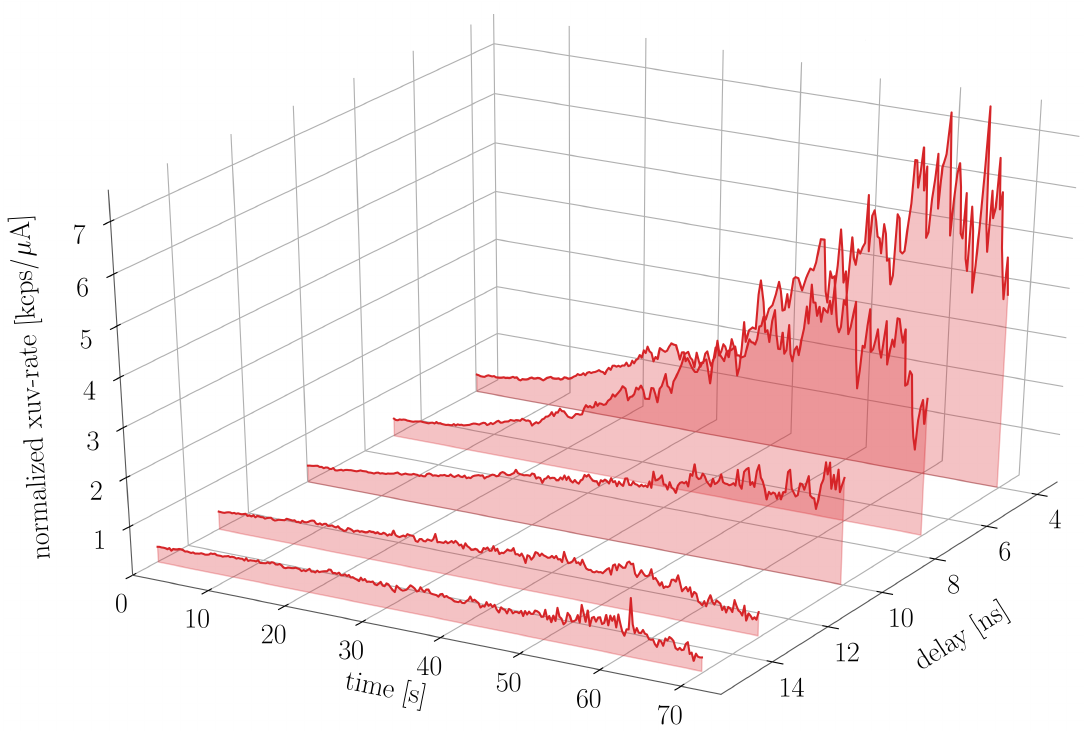
Figure 3. Fluorescence rate of 12 C 3 + ions plotted as a function of the delay of the laser pulses with respect to the ion bunches, as detected by the XUV detection system at the ESR. For these measurements, there were 7 ion bunches stored in the ESR, the repetition rate of the laser pulses was ∼ 9MHz, and the laser wavelength was